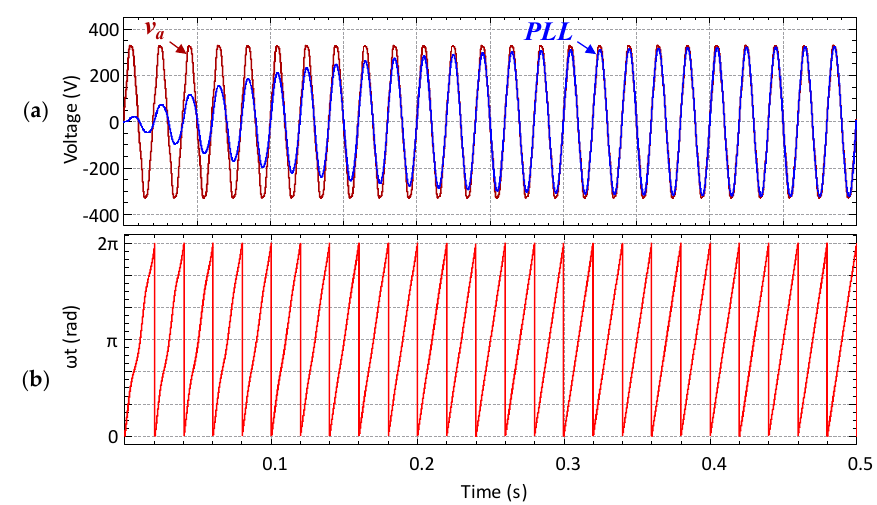
Figure 21. Simulation results of the PLL: ( a ) power grid voltage and PLL output; ( b ) angle output.